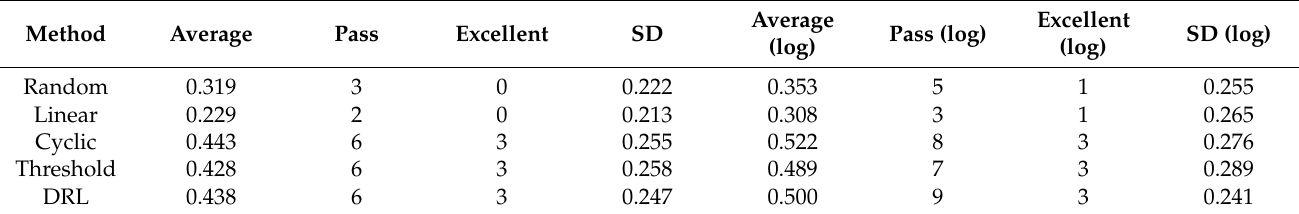
Table 1. The results of EFC that consider the knowledge points association.